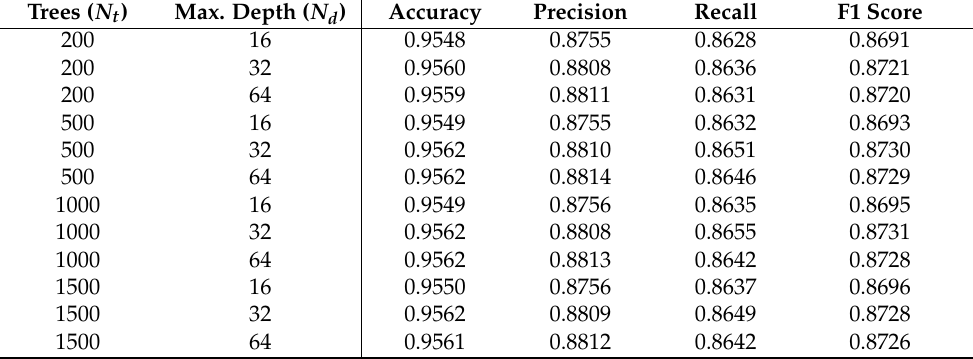
Table 1. Search for suitable number of trees and maximum depth for